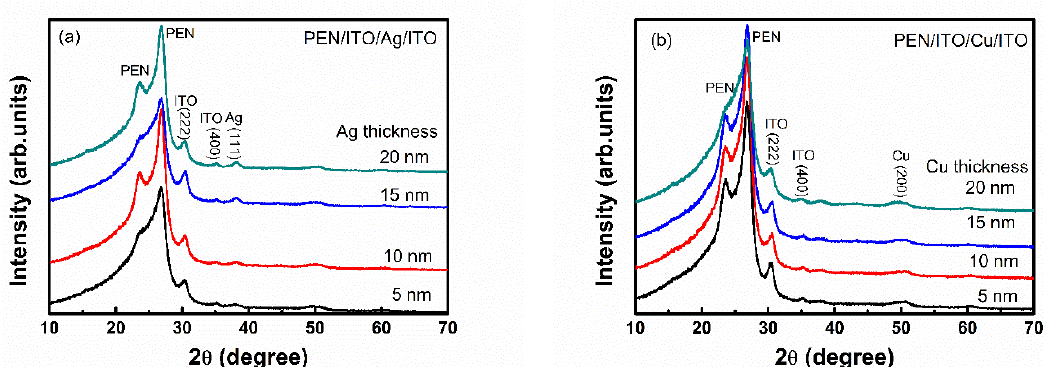
Figure 1. GIXRD plots obtained from ( a ) ITO/Ag/ITO and ( b ) ITO/Cu/ITO samples as functions of the Ag and Cu thick ness on the PEN substrate. Table 1. The Ag (111) and Cu (200) crystallite sizes with different metal interlayer thicknesses on the PEN substrate (nm). Thickness Sample